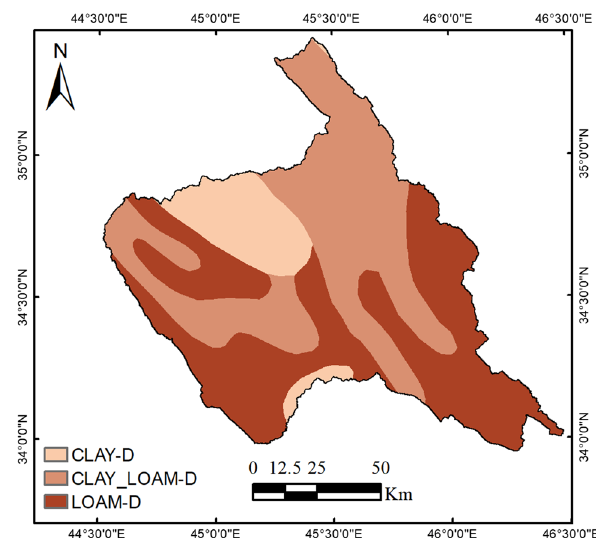
Fig. 4 Digital elevation model of Hemren dam reservoir catchment